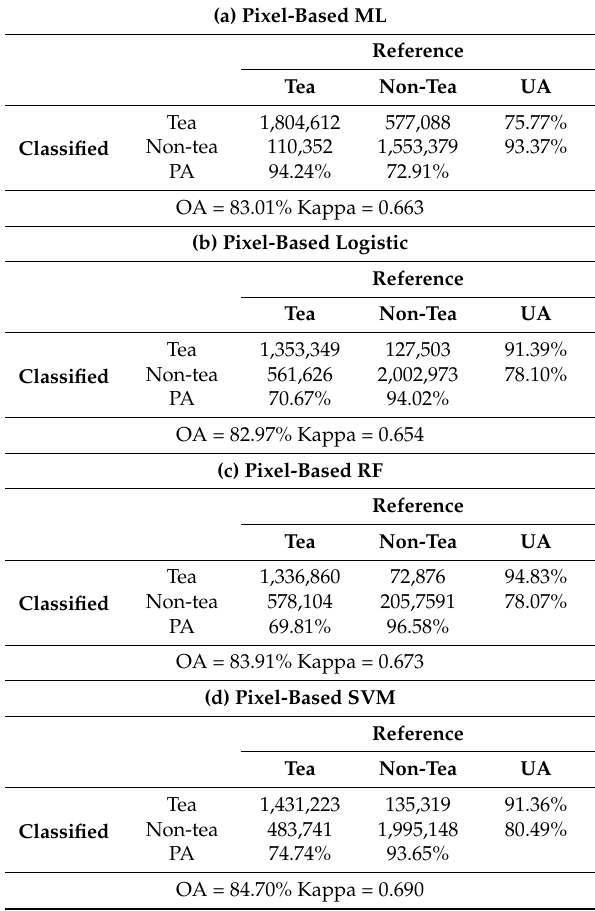
Table 5. Error matrix for pixel-based classification with 34 selected variables; the unit is pixel